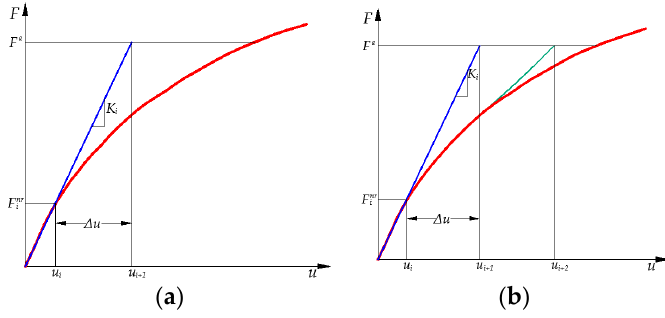
Figure 10. Example of Newton-Raphson Solution ( a ) First Iteration ( b ) Next Iteration.